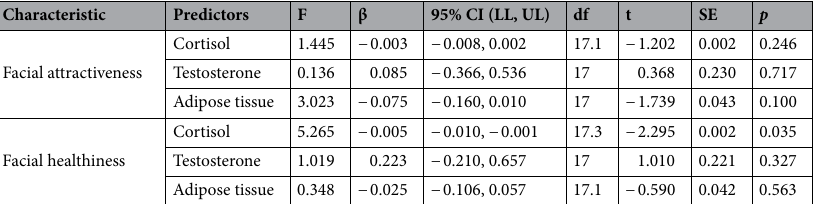
Study 2: association between perceived cheek patch healthiness and colouration. A linear mixed-effects model shows that perceived cheek patch healthiness (R 2 C = 0.478, R 2 M = 0.025) was not predicted by levels of specific antibodies (Table 2). In a linear mixed-effects model testing the influence of skin colour on perceived cheek patch healthiness (R 2 C = 0.471, R 2 M = 0.164), cheek redness negatively predicted perceived cheek patch healthiness. For detailed information, see Table 6.